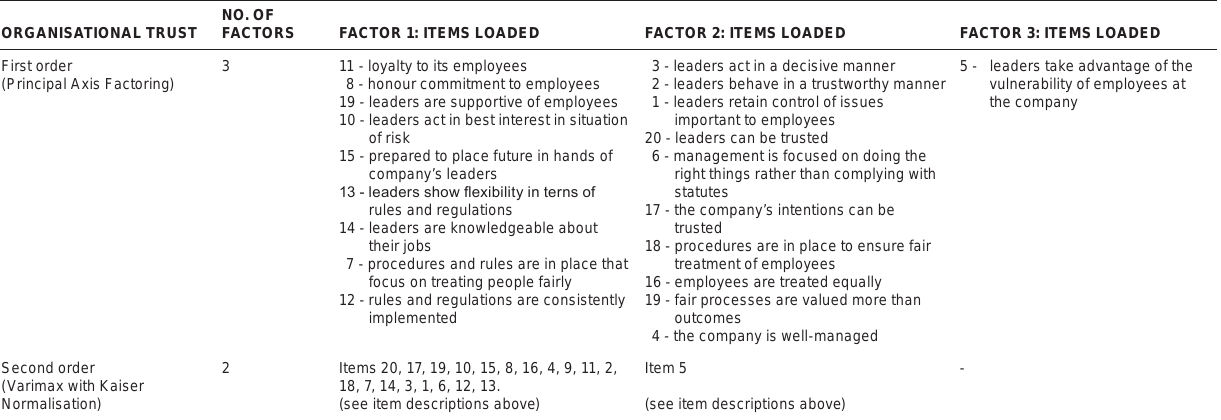
taBle 2 Results of factor analysis – organisational